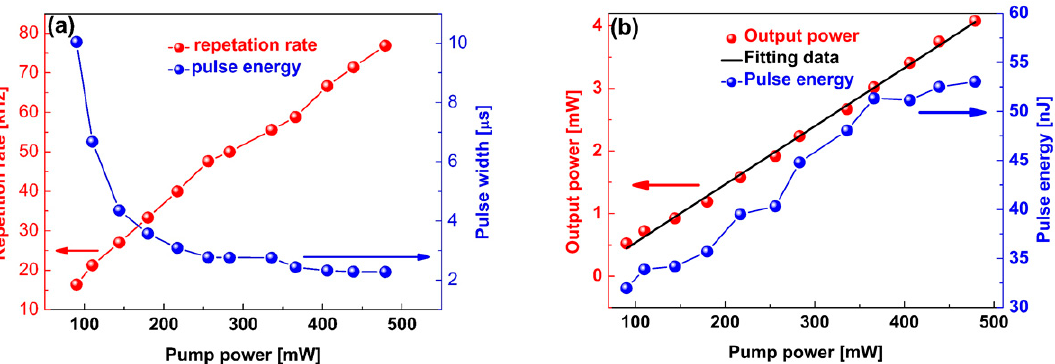
Figure 8. ( a ) Repetition rate and pulse duration versus different pump power; ( b ) Output power and pulse energy versus different pump power. Table 1. Performance comparison of dual-wavelength Q-switched fiber lasers with 2D materials.